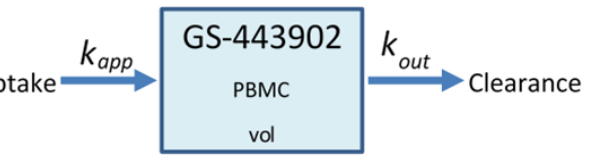
Figure 1. Schematic diagram of the minimalized PBPK model of remdesivir. PBMCs are a surrogate for lung alveolar epithelial cells for GS-443902. Table 1. List of parameters used for the minimal PBPK model of remdesivir. Parameter Value